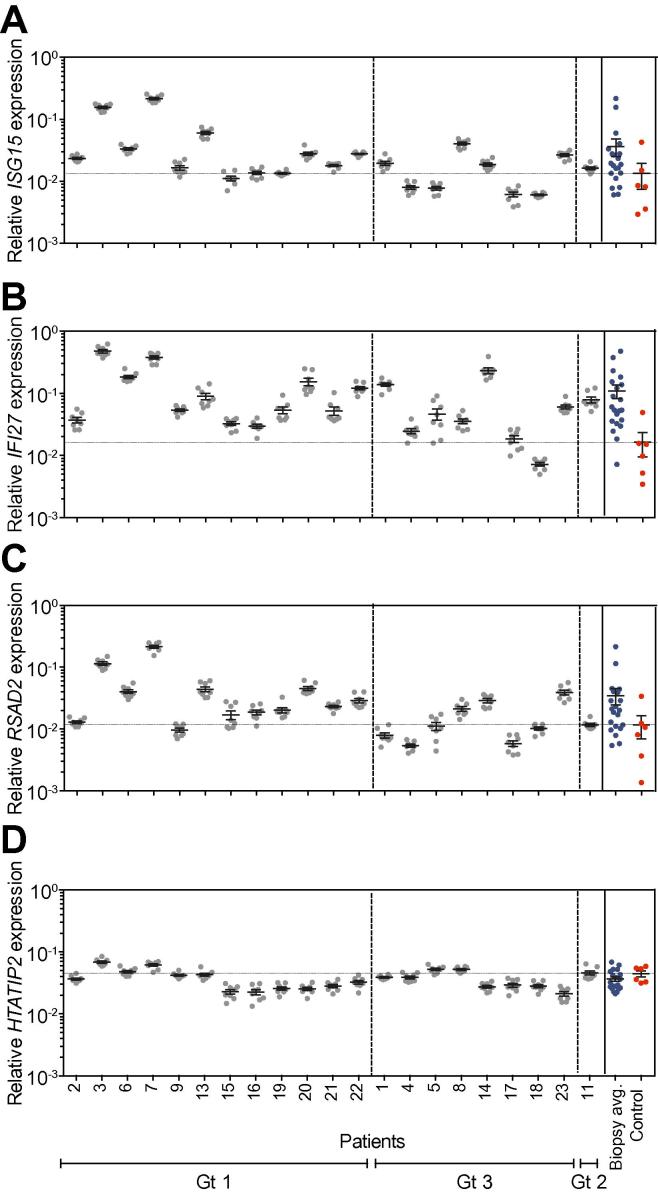
Interferon stimulated gene expression in the HCV infected liver. RNA was extracted from biopsies sampled from the 8 segments of the explanted liver of patients diagnosed with chronic hepatitis C (Genotype 1 [Gt1] n = 13; Genotype 3 [Gt3] n = 7 and Genotype 2 [Gt2] n = 1) and from a single biopsy collected from 6 normal controls. The mRNA levels for ISG15 (A), IFI27 (B), RSAD2 (C) and HTATIP2 (D) were quantified and normalized with an internal GAPDH mRNA expression referent. Data are presented for each biopsy sample showing the mean expression levels ± SD and the average values for the total liver denoted in the right-hand panel along with controls (red). The dashed horizontal line denotes the mean expression of normal biopsies.